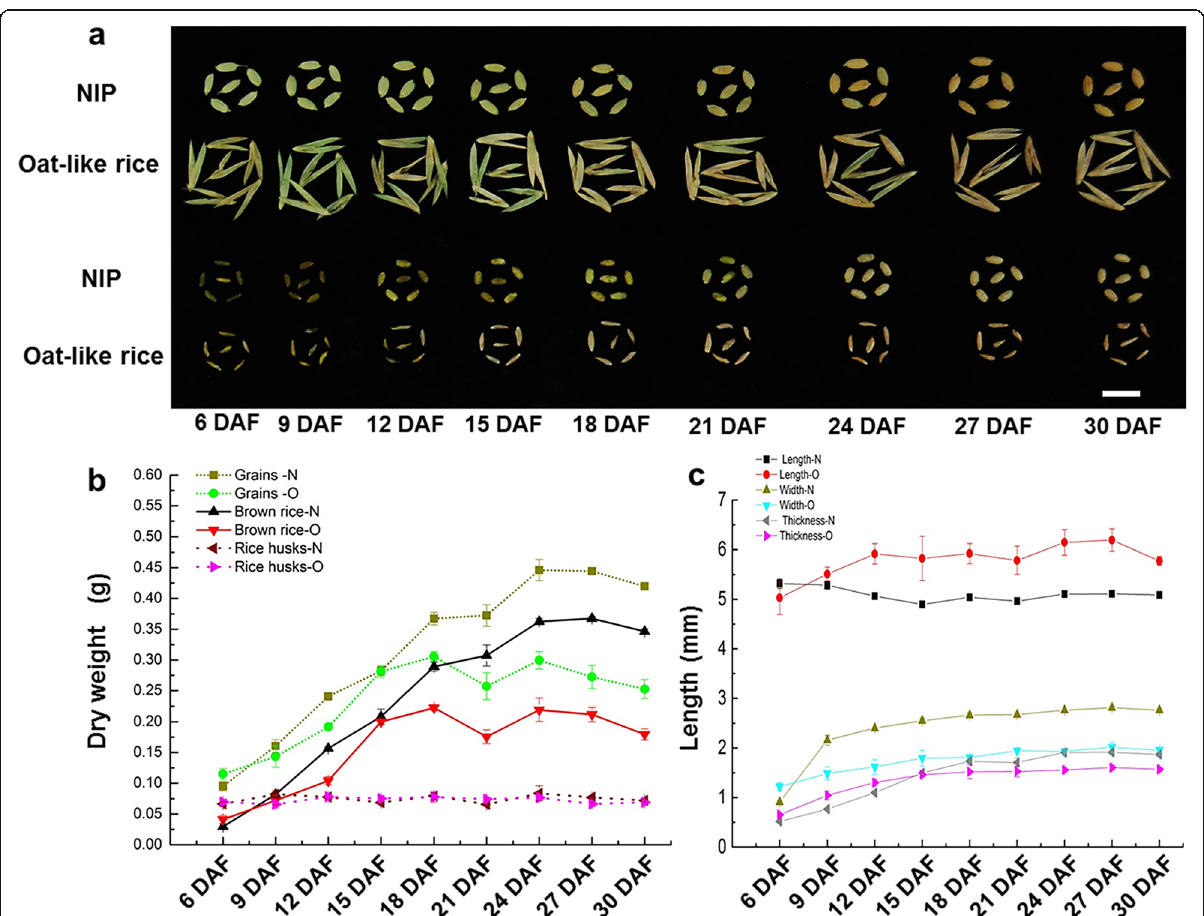
Fig. 3 Time course analysis of the grain development between Oat-like rice and NIP. a Appearance and phenotypes of grains and brown rice of Oat-like rice and NIP at various developmental stages after fertilization. b Comparison of grain-filling process between Oat-like rice and NIP. c Comparison of brown rice length, brown rice width and brown rice thickness at various developmental stages after fertilization between Oat-like rice and NIP. N: NIP; O: Oat-like rice. Bar: ( a ) 5 mm. Data presented are mean values ± SDs [ n = 3 replicates (each replicate consisting of 20 grains, brown rice and or pairs of lemma and palea) in b - c